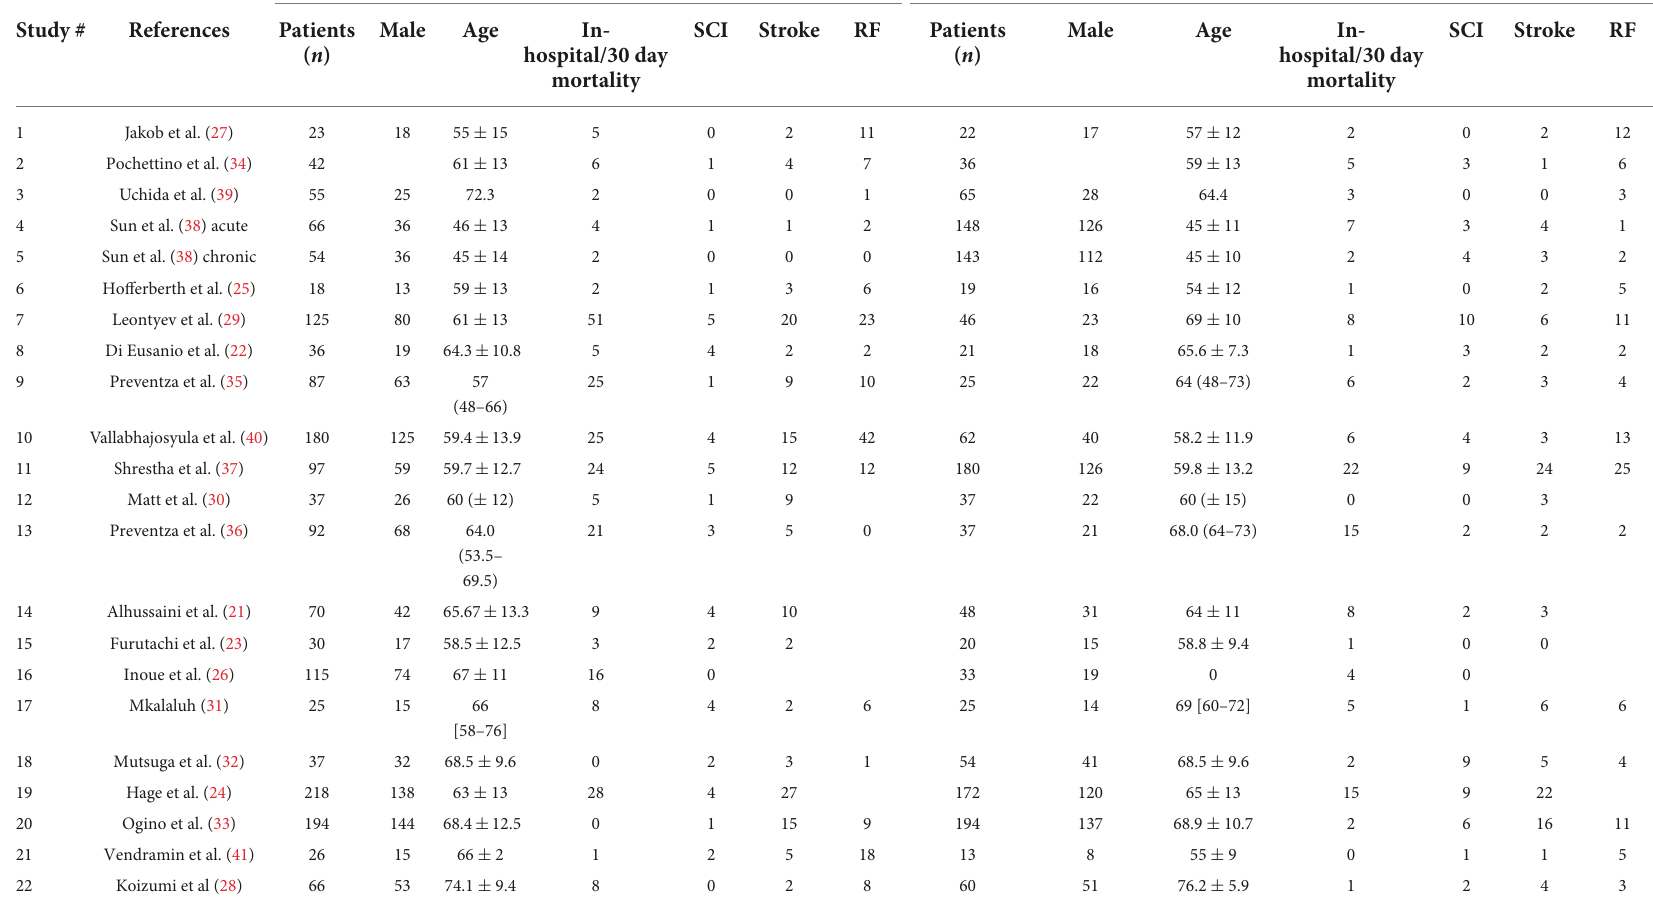
TABLE 2 Included studies and patients’